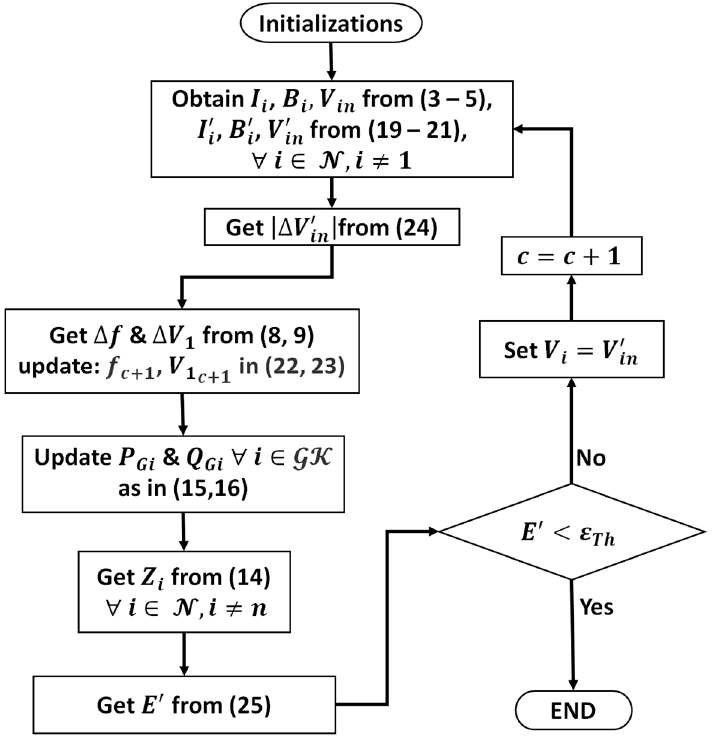
Figure 4. Improved special backward/forward sweep load flow method.